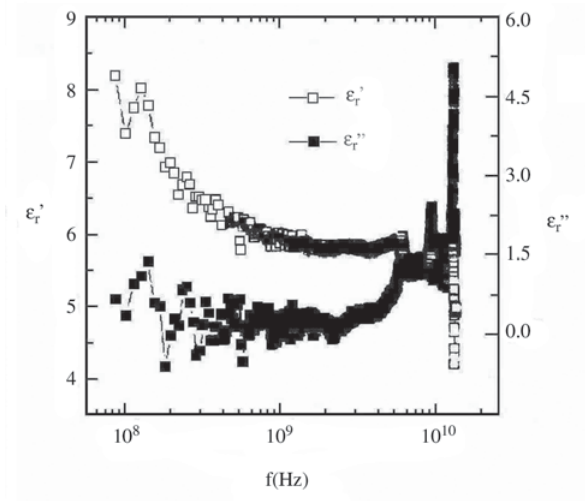
Figure 2. Dielectric response for the alumina ceramic by using the coaxial probe method, at room temperature.